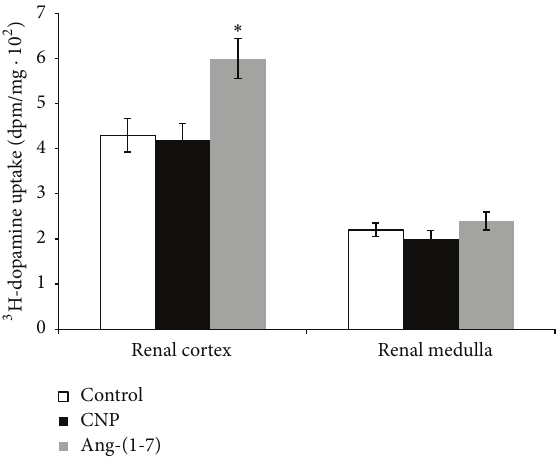
Figure 3: Effects of 100 nM CNP and 100 nM Ang-(1-7) on 3 H- dopamineuptakeinexperimentscarriedout invitro inisolatedrenal cortex and medulla samples. 3 H-dopamine uptake is expressed as dpm/mg ± SEM. ∗ 𝑝 < 0.05 compared with control. Number of samples: 8–12.